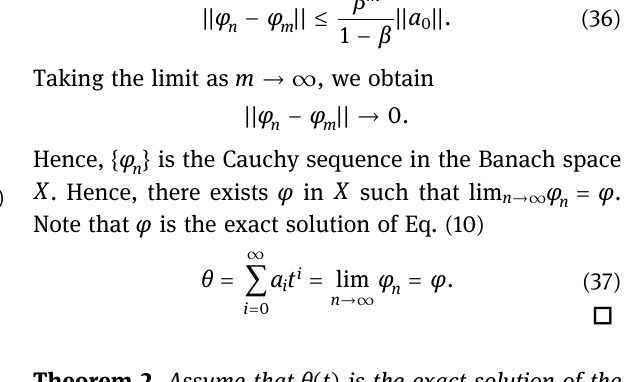
20 ⟨ ⟩ with step - size k